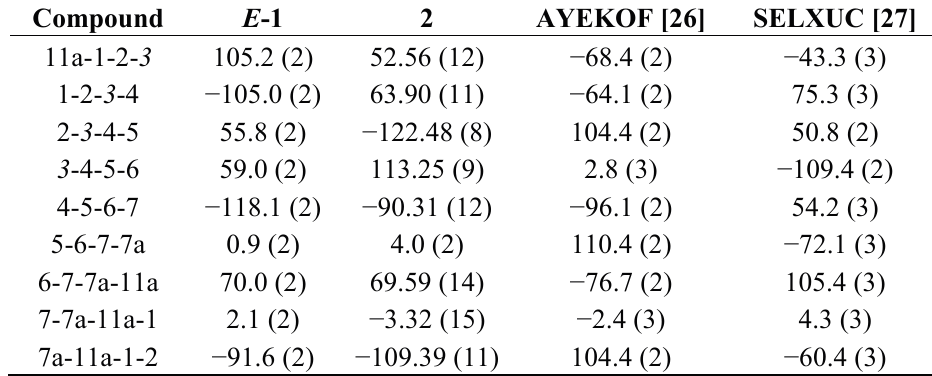
Figure 2. Molecular projections of E - 1 ( a ); 2 ( b ), normal to the “planes” of their “macrocycle” rings; the R enantiomer, arbitrarily adopted as the asymmetric unit in a centrosymmetric space group, is shown in (a). Table 1. “Macrocycle” torsion angles (degrees) ( E -1 , 2 ; counterpart values for (CCDC) AYEKOF [26], SELXUC [27] are also given.). Atoms are denoted by number only, N italicized ; note that atom 4 in 2 is